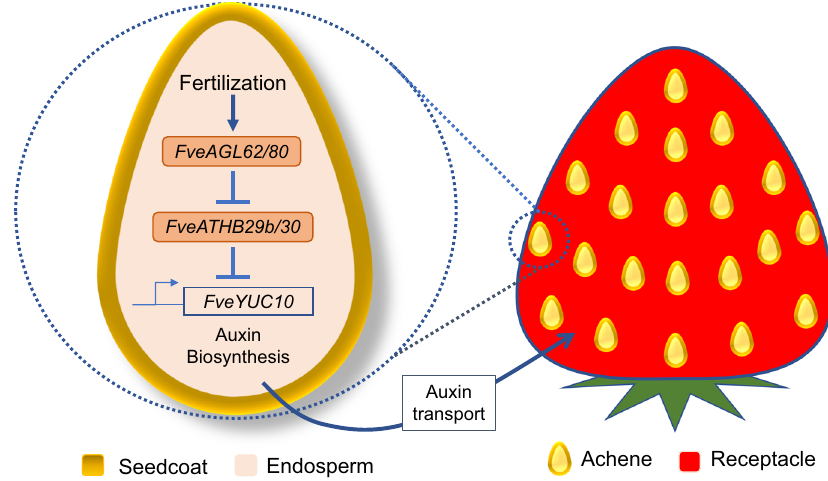
Fig. 7 A model illustrating the FveAGL62-FveATHB module. Upon fertilization, FveAGL62 and FveAGL80 expression is induced in the endosperm and the FveAGL62/FveAGL80 heterodimers act to switch off the transcription of FveATHB genes, lifting the transcriptional repression of auxin biosynthesis genes such as FveYUC10 , leading to the synthesis and accumulation of auxin. Upon being transported to receptacle, auxin stimulates receptacle fruit